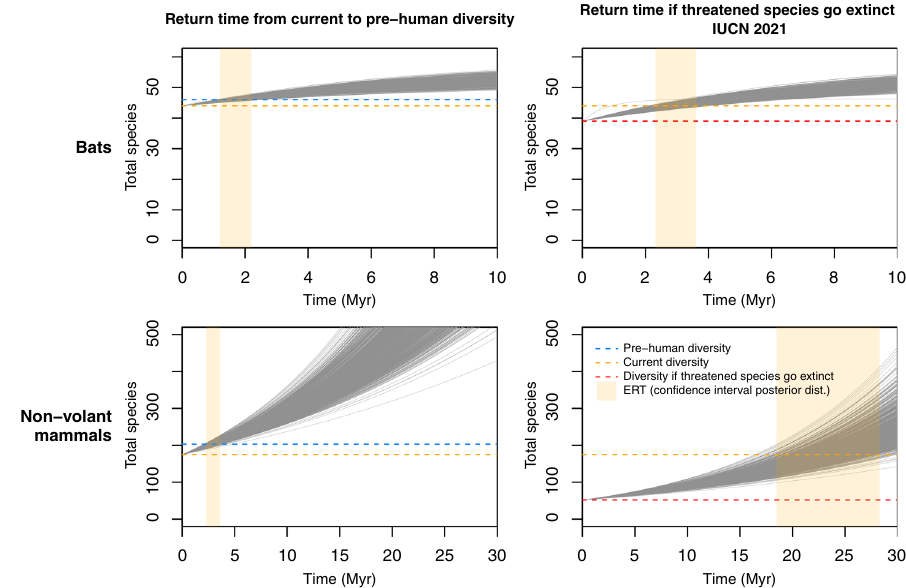
Fig. 3 | Expected future diversity for bats and non-volant mammals on Mada- gascar. Two scenariosareshown: returntime from currenttopre-humandiversity (left panels); and return time to contemporary diversity if species classi fi ed as threatened by the IUCN in 2021 go extinct (right panels). Based on fi tting the M26 model to 1000 trees from the posterior distribution of the main dataset, D1. The